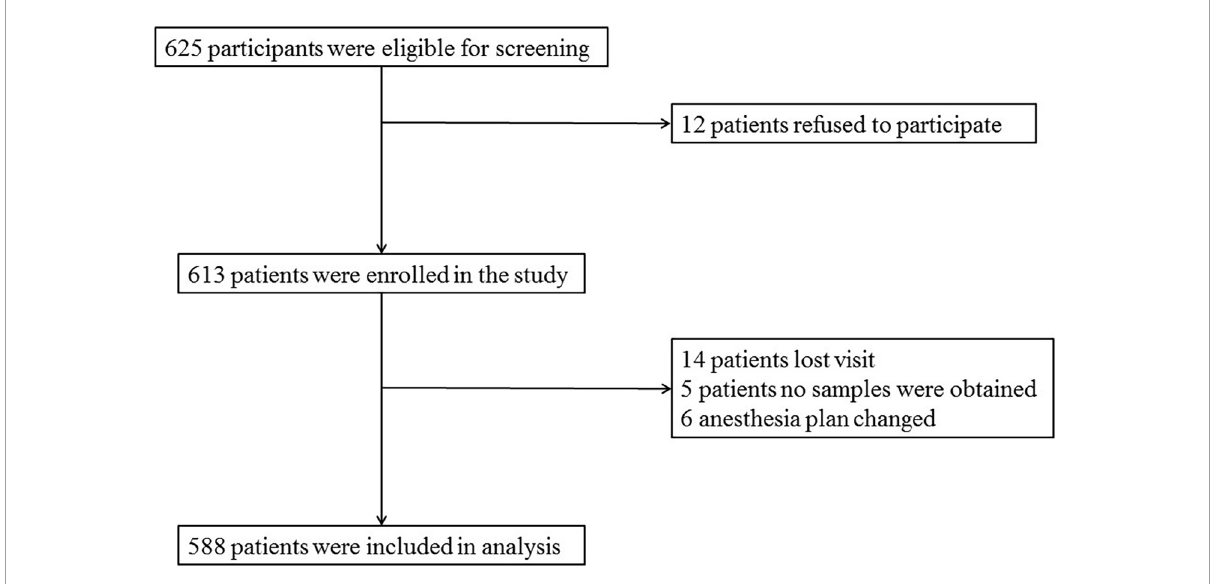
FIGURE1 Diagram of study